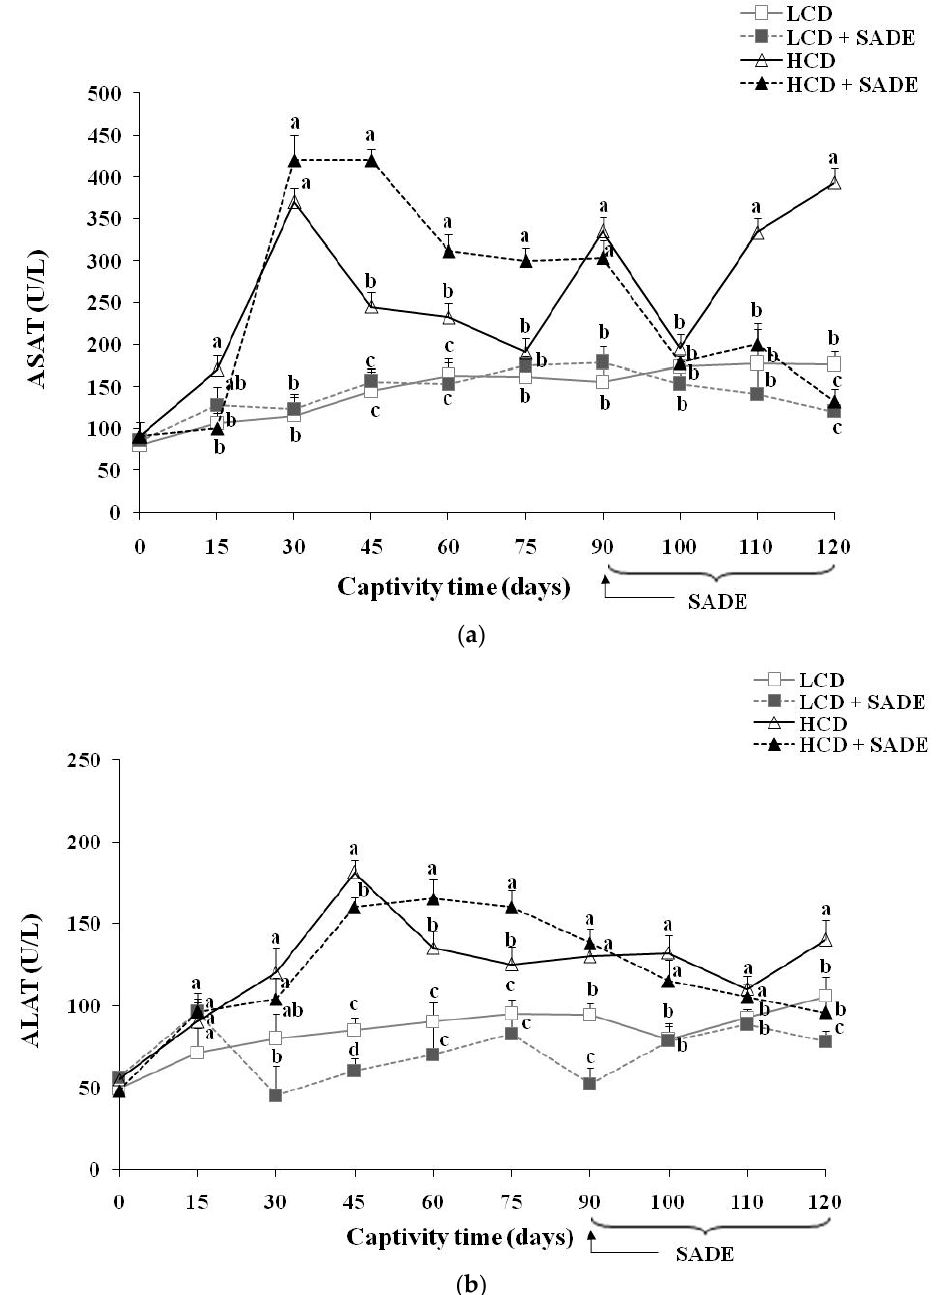
Figure 6. ( a ) ASAT activity (U/L) in P. obesus . LCD: animals group fed with natural low-calorie vegetable diet, LCD + SADE: LCD treated with S. arabica decocted, HCD: rats fed with high-calorie diet and HCD + SADE: rats fed with high-calorie diet treated with S. arabica decocted extract. Results are presented as means ± SD for ten rats in each group. Means not sharing the same superscript letters (a, b, c) for each captivity time are significantly different between groups (Tukey’s post hoc test, p < 0.05). “a” denotes the highest value and “c” represents the lowest value. ( b ) ALAT activity (U/L) in P. obesus . LCD: animals group fed with natural low-calorie vegetable diet, LCD + SADE: control treated with S. arabica decocted, HCD: rats fed with high-calorie diet and HCD + SADE: rats fed with high-calorie diet treated with S. arabica decocted extract. Results are presented as means ± SD for ten rats in each group. Means not sharing the same superscript letters (a, b, c, d) for each captivity time are significantly different between groups (Tukey’s post hoc test, p < 0.05). “a” denotes the highest value, and “d” represents the lowest